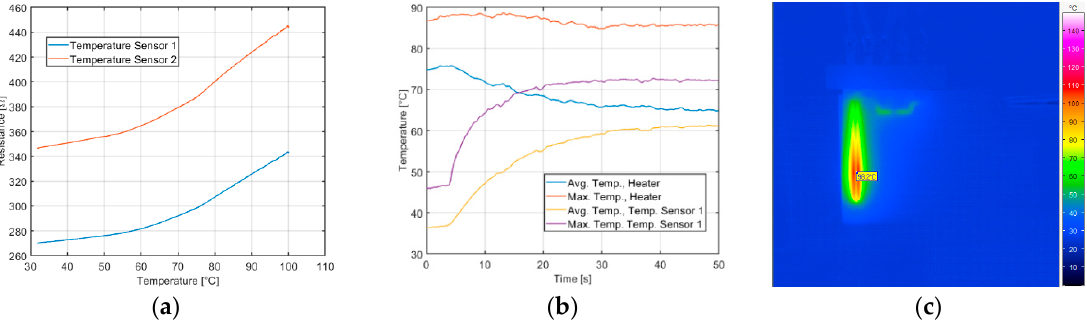
Figure 3. ( a ) Measured resistance vs. temperature profile from carbon resistances printed on COC foil. TCR Temp. Sensor 1: 4140 ppm/°C, TCR Temp. Sensor 2: 3959 ppm/°C ( b ) Temperature time profile from infrared imaging on working microfluidic device, 0.1 mL min − 1 ( c ) Thermal infrared imaging displaying heater temperature emission at 240